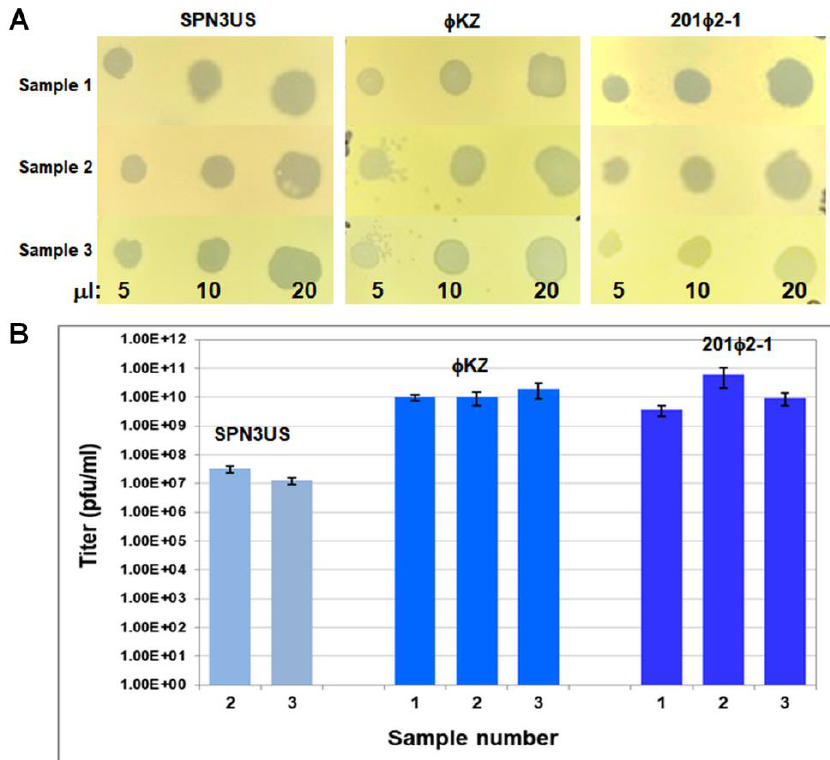
Figure 4. Qualitative viability assessments for all three phages studied here. ( A ) Three samples of phages SPN3US, ϕKZ and 201ϕ2-1 that had been fluorescently labelled and treated were spotted onto the lawns of their respective bacterial hosts in three replicate experiments. Volumes of phage spotted are indicated at the bottom of the image. ( B ) Enumeration of viable particles (plaque-forming units, pfu) of the samples in (A) for phages SPN3US, ϕKZ and 201ϕ2-1, with the exception of SPN3US sample 1 which was not able to be titered.